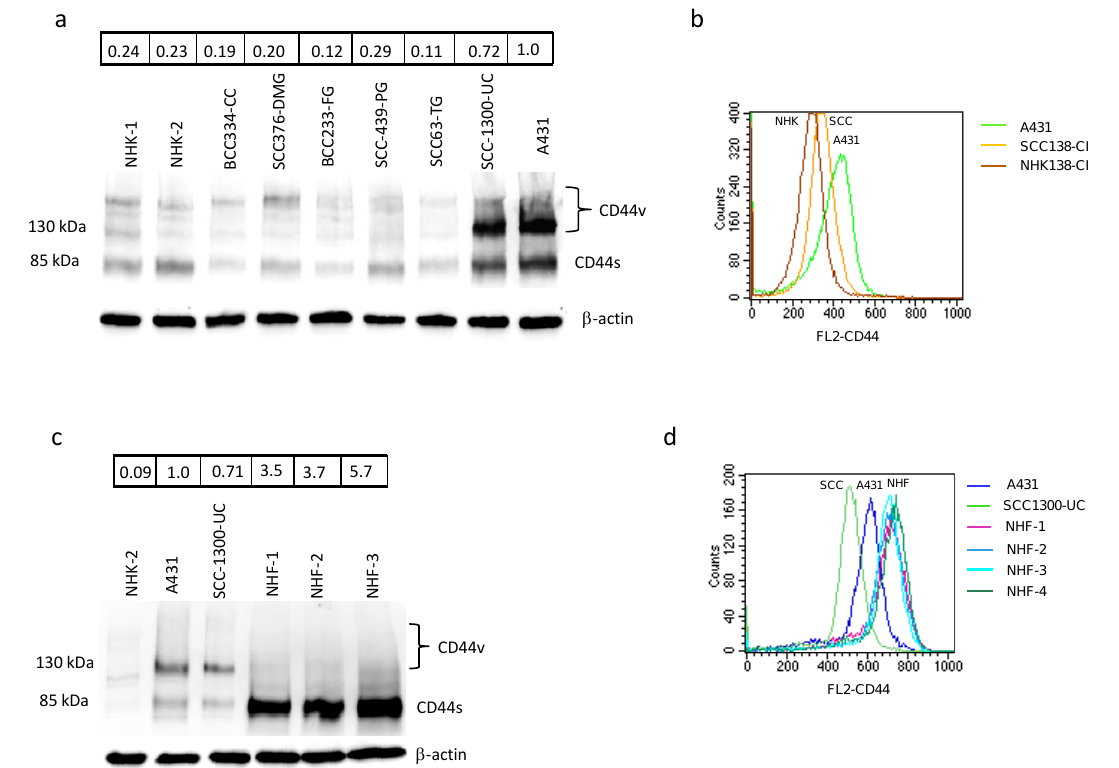
Figure 3. ( a ) Western blot and densitometric analysis of CD44 expression in NHKs and carcinoma cells. Data evidenced that A431 and SCC1300-UC patient-derived cells expressed the CD44v isoform in addition to the standard isoform (CD44s). ( b ) One representative immunostaining of plasma membrane CD44 expression in carcinoma cells and normal keratinocytes. Data demonstrated lower intensity in freshly isolated carcinoma cells (SCC138-CI) compared to the A431 carcinoma cell line. NHKs isolated from healthy skin of the same patient (NHK138-CI) presented the lowest quantity of CD44. ( c ) Western blot and densitometric analysis of CD44 expression in carcinoma cells and fibroblasts. Similar to ( a ), semi-quantitative analysis of CD44 staining showed high expression in all NHF cell cultures analyzed, compared to A431, and in freshly isolated carcinoma cells (SCC1300-UC). ( d ) One representative immunostaining of plasma membrane CD44 expression in carcinoma cells and normal